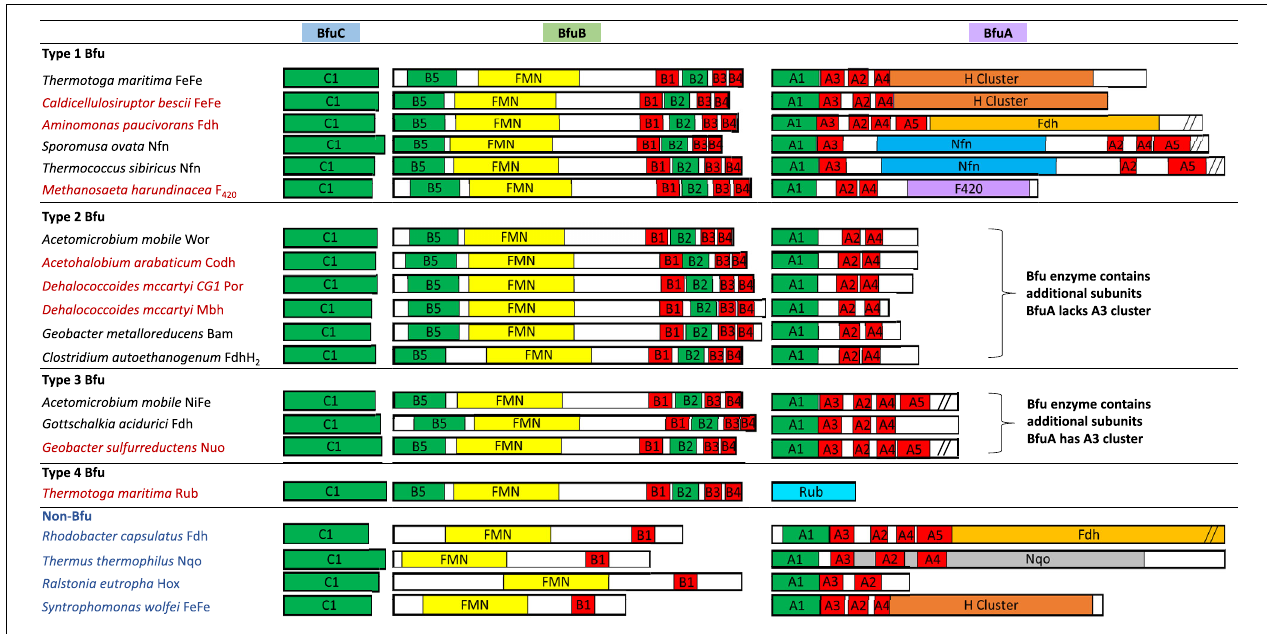
FIGURE 4 | Redox cofactor contents of the BfuABC subunits in the four types of characterized and predicted enzyme in the BfuABC family. Characterized and predicted enzymes and their microbial sources are shown in black and red font, respectively. The cofactors in homologous subunits in non-bifurcating non-Bfu enzymes and their sources are shown in blue font. The cofactors in the BfuBC subunits are conserved in all Bfu complexes but not in homologous non-Bfu enzymes. [2Fe-2S] clusters are indicated by green boxes, [4Fe-4S] by red boxes, FMN by yellow boxes, and additional domains such as those of the H-cluster, pyranopterin, Nfn-like, F 420 dehydrogenase, rubrerythrin, and Nqo are indicated by brown, orange, blue, purple, light blue, and gray boxes,